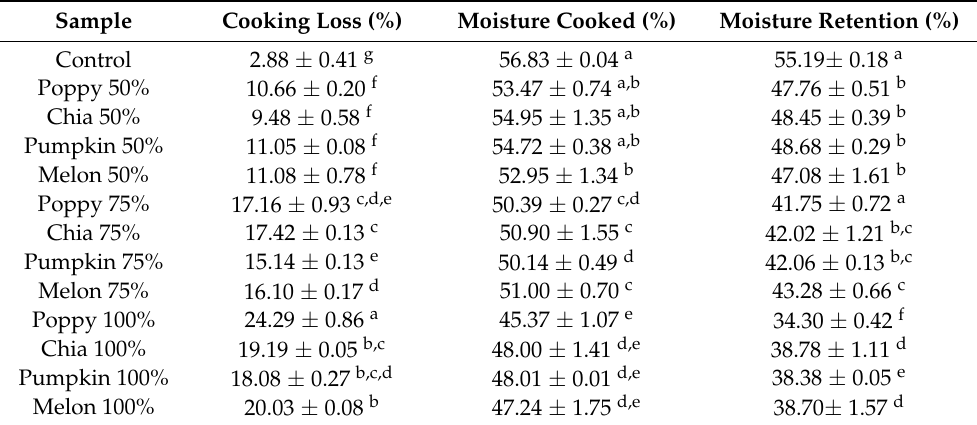
Table 2. Results obtained for cooking loss, moisture of cooked samples, and moisture retention in fresh deer